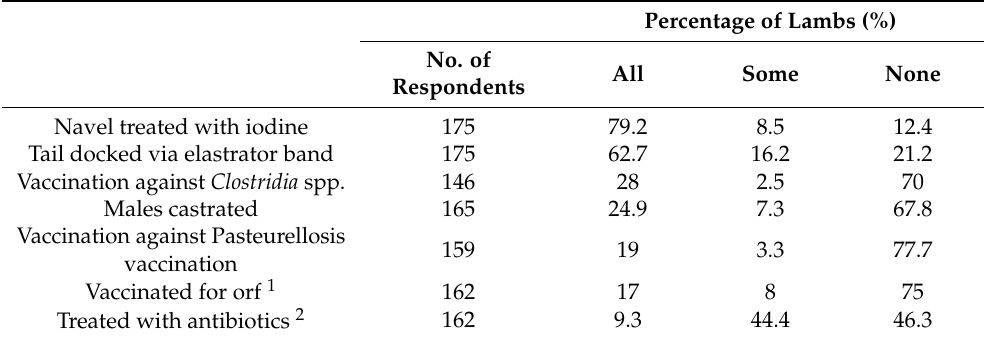
Table 7. Management practices undertaken on live-born lambs within two months of birth ( n = 177